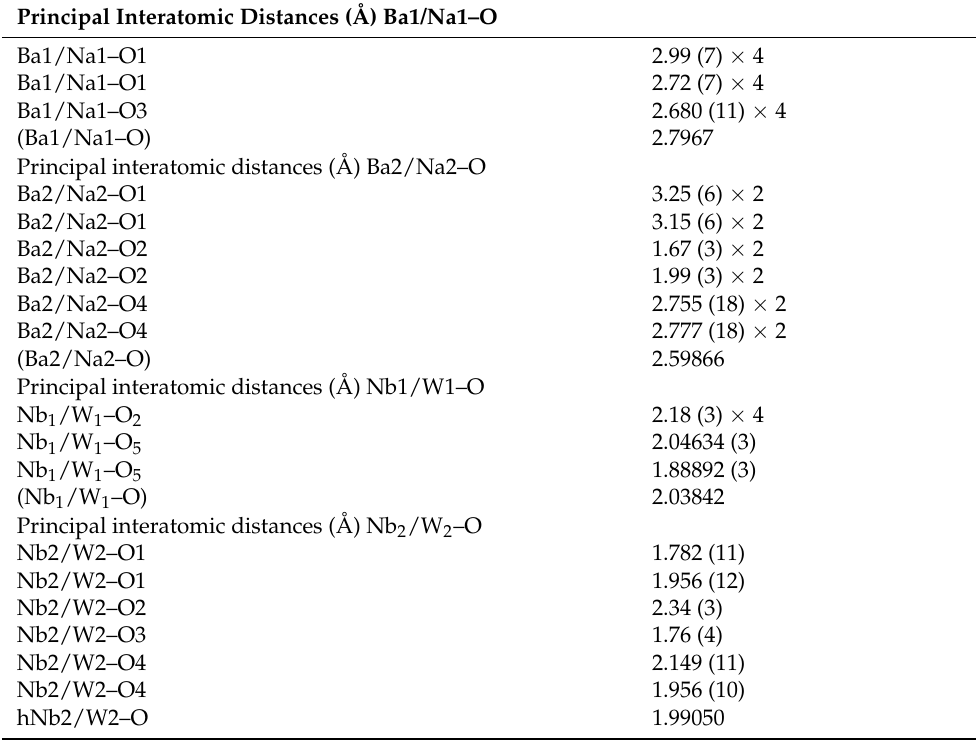
Table 3. Some interatomic distances (Å) of the crystalline phase Ba 0.54 Na 0.46 Nb 1.29 W 0.37 O